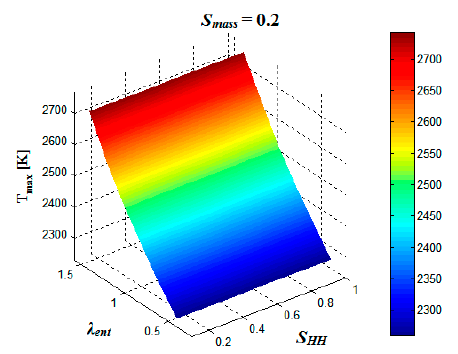
Figure 16. Peak temperature values when S mass is fixed.